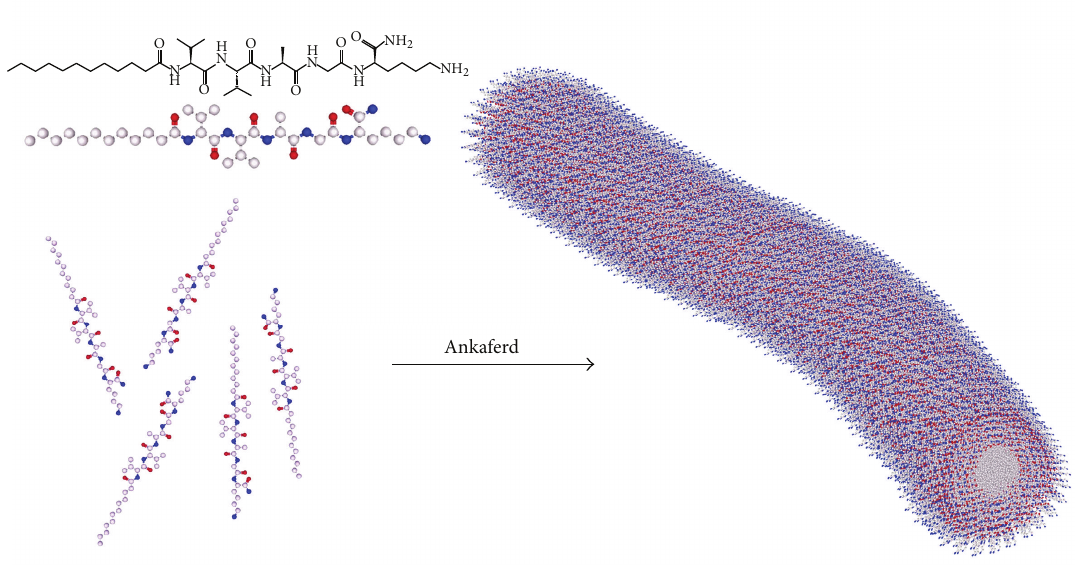
Figure 2: Schematic representation of ABS Nanohemostat formation by self-assembly of peptide amphiphile molecules into nanofibers upon addition of Ankaferd